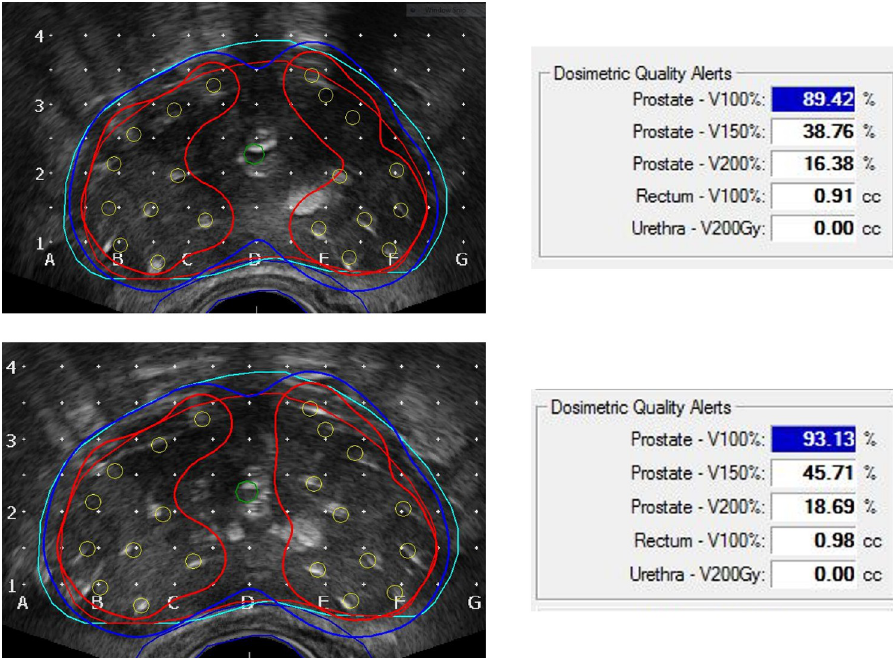
Fig 4. An exemplary case of cold-spot reduction around the urethra and improvement of dosimetric parameters. Red lines are isodose lines for prostate V100%, orange circles indicate the actual implanted seed locations, and real- time dose distribution was calculated instantaneously according to these locations. With real-time intraoperative optimization, both better dose coverage and maintained dose constraints were possible.